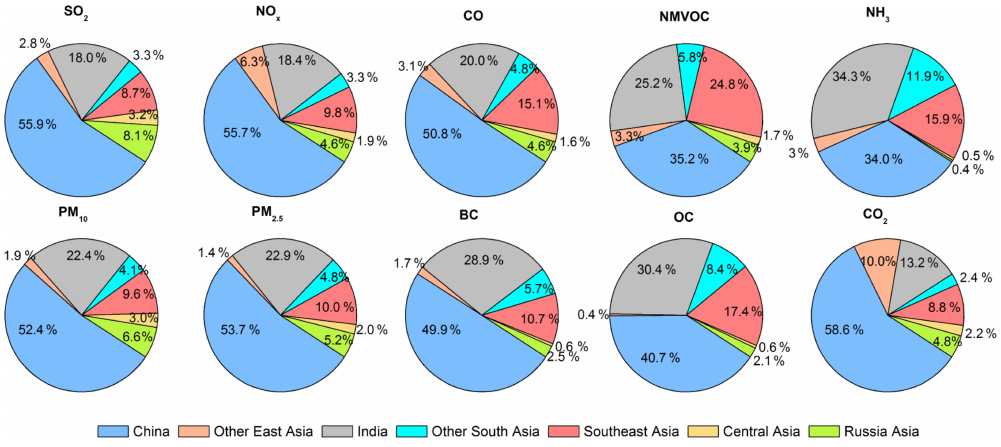
Figure 5. Emissions distributions by Asian regions in